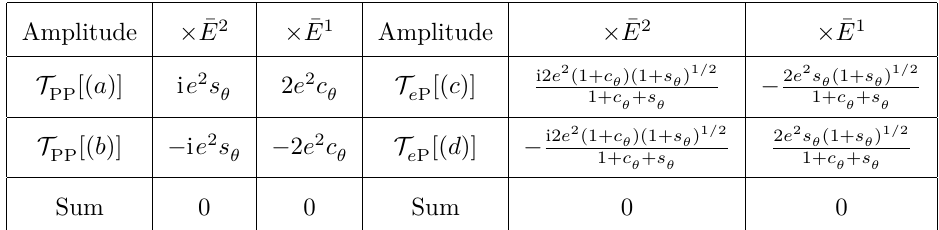
Table 2 . Energy cancellations in the scattering amplitudes of 3d topologically massive spinor QED, T [ e + e − → A A ] = T [( a )] + T [( b )] and T [ e − A → e − A ] = T [( c )] + T [( d )] , where the P P PP PP P P e P e P notations are defined as ¯ E = E/m and ( s , c ) = (sin θ, cos θ ) with θ denoting the scattering angle. θ θ Each full amplitude equals the sum of individual diagrams ( a ) + ( b ) and ( c ) + ( d ) , respectively, as shown in figure